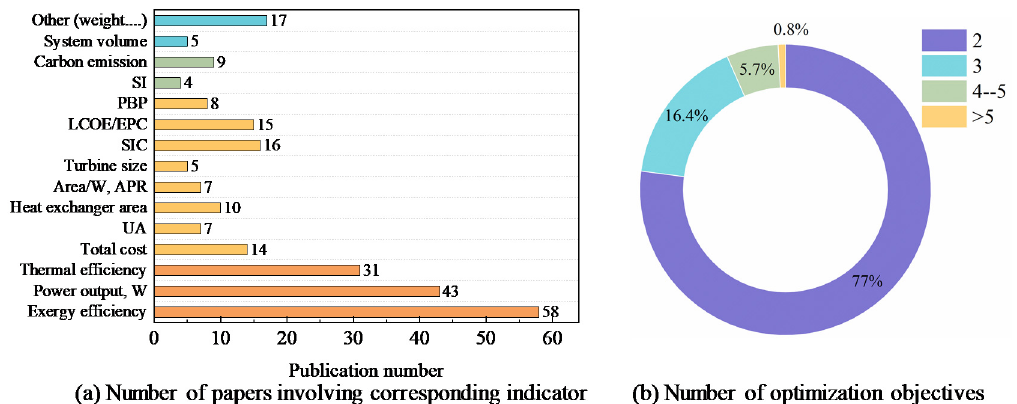
Figure 2. Classification and statistical results of optimization objectives.